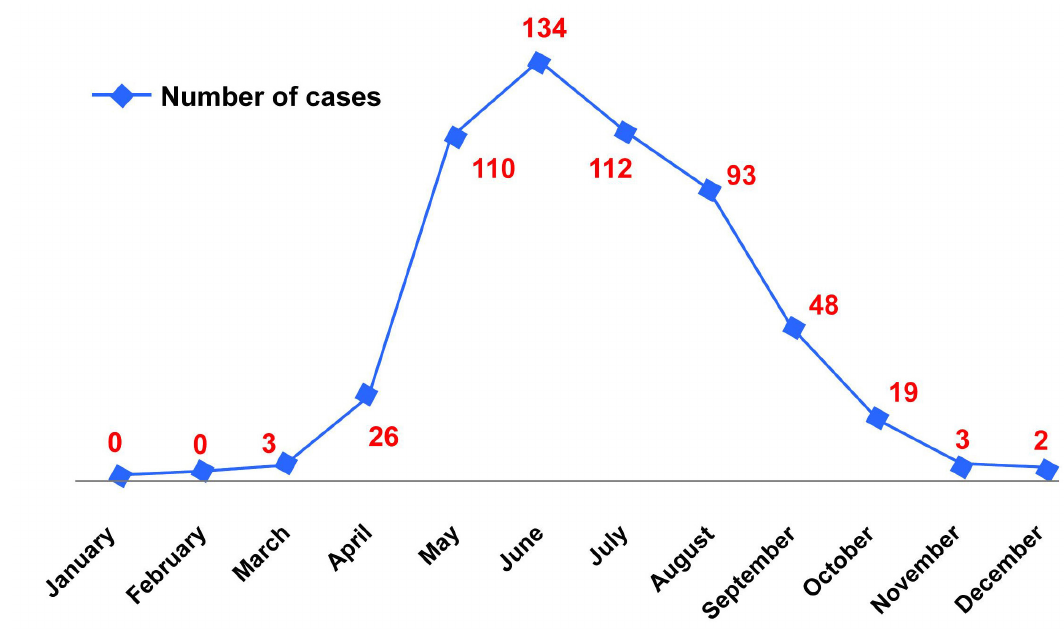
Figure 2. Distribution of snakebites according to months. Table 1. Distribution of snakebites according to epidemiological characteristics of